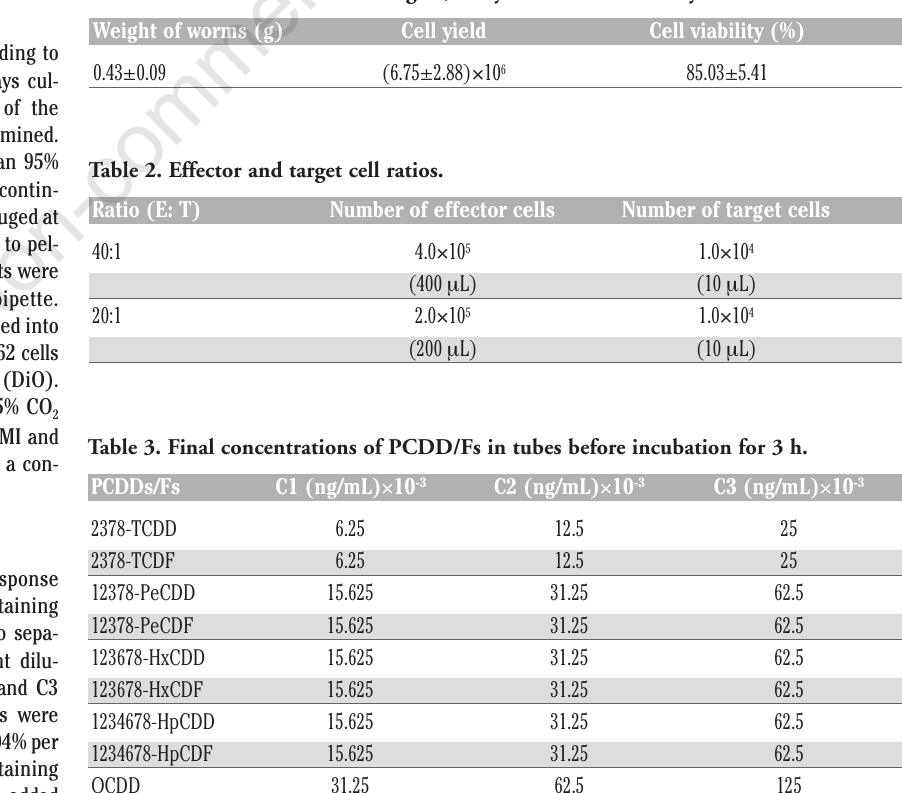
Table 1. Mean values of worm weights, cell yield and cell viability.